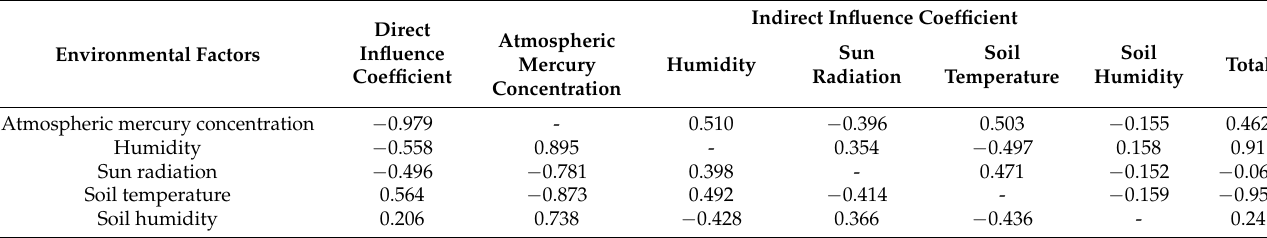
Table 7. Path analysis of the mercury flux and environmental factors during the vegetative reproduction stage of Leymus chinensis . Indirect Influence Coefficient Direct Atmospheric Influence Environmental Factors Atmospheric mercury